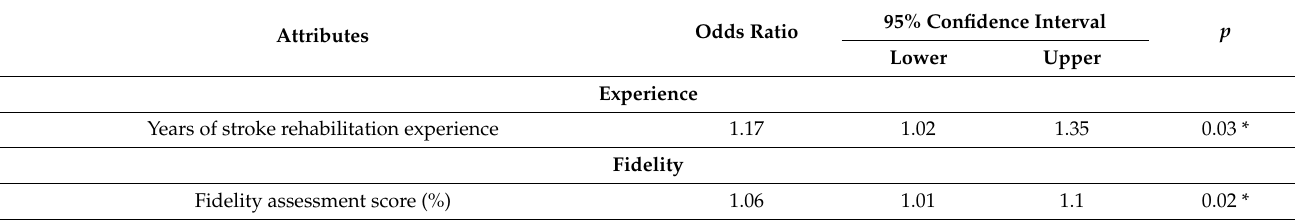
Table 5. Relationship between OT attributes and stroke survivor RTW outcomes at 12 months post-randomisation through univariate logistic